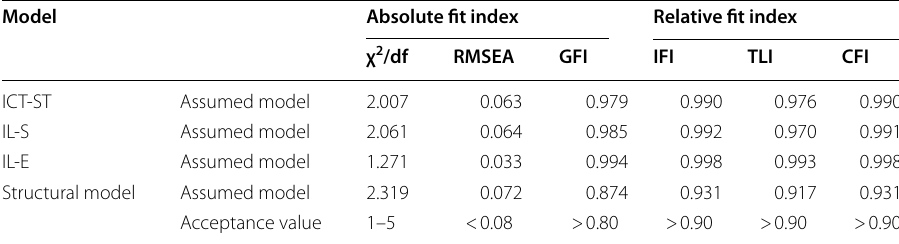
χ 2 absolute/predictive fit chi‑square; RMSEA root mean square error of approximation, GFI goodness‑of‑fit index, = IFI incremental fit index, TLI Tucker–Lewis index, CFI comparative fit index